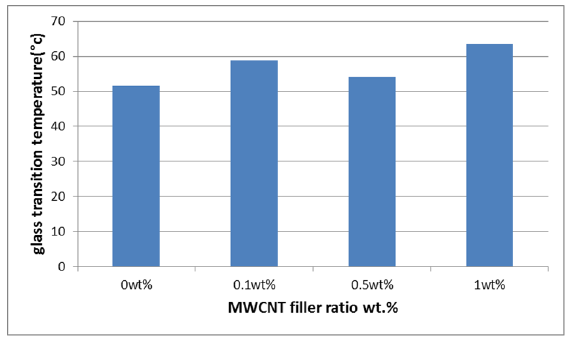
Fig. 12. Glass transition temperatures, Tg, results for the nanocomposites with different MWCNT Ratios.